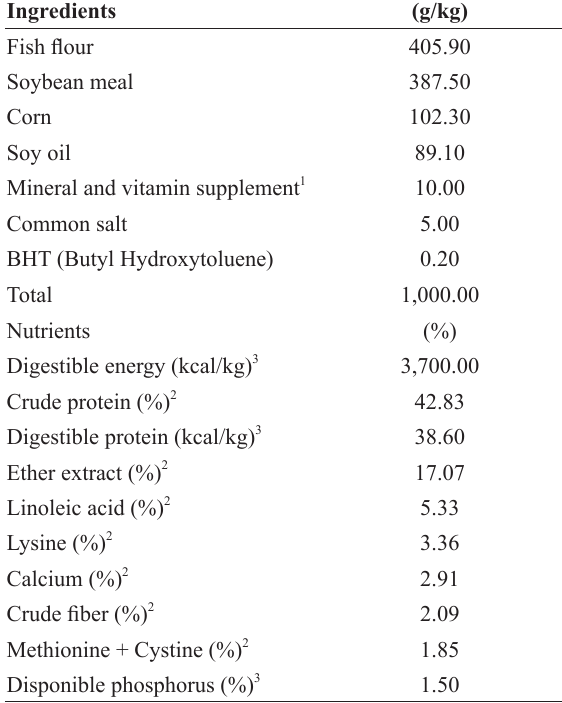
Chemical composition of the diet experimental (natural matter) of Nile tilapia